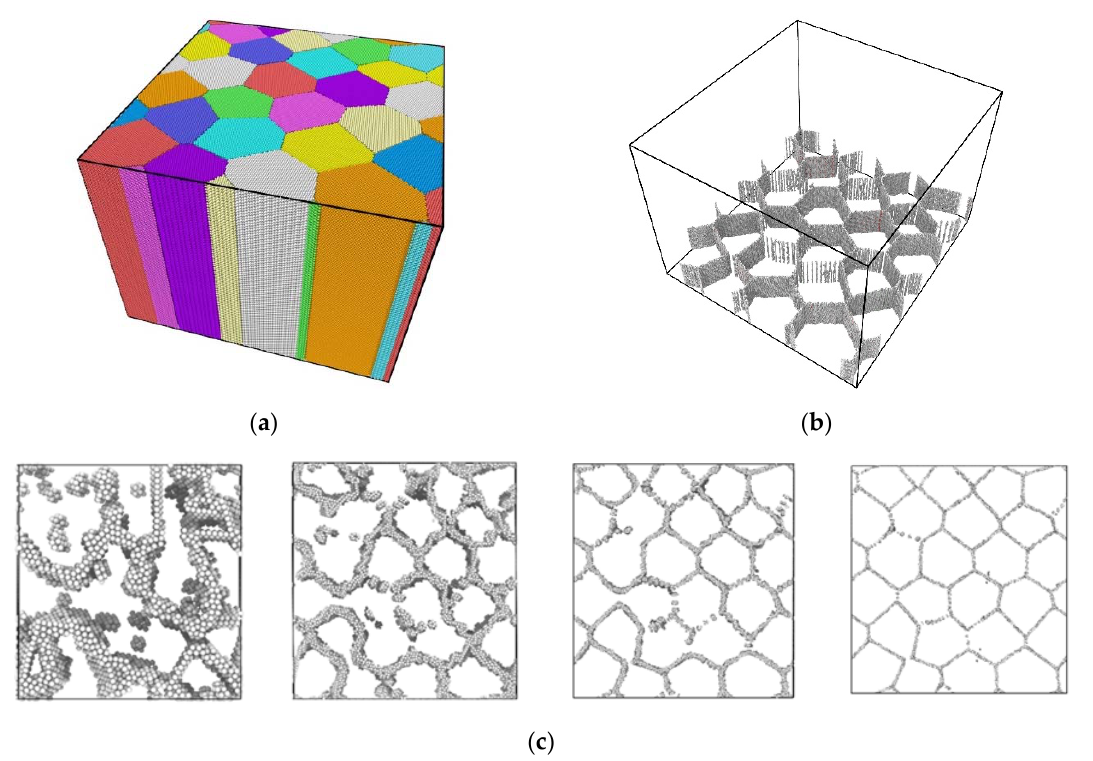
Figure 1. ( a ) the ideal initial (unrelaxed) structure of the largest sample and ( b ) a partial view of it after relaxation at 300 K with atoms depicted according to a coordination code, bcc atoms made invisible [12]. ( c ) a top view of the four samples (in order of increasing size); relaxed state with bcc atoms made invisible (the size of figures has been normalized).